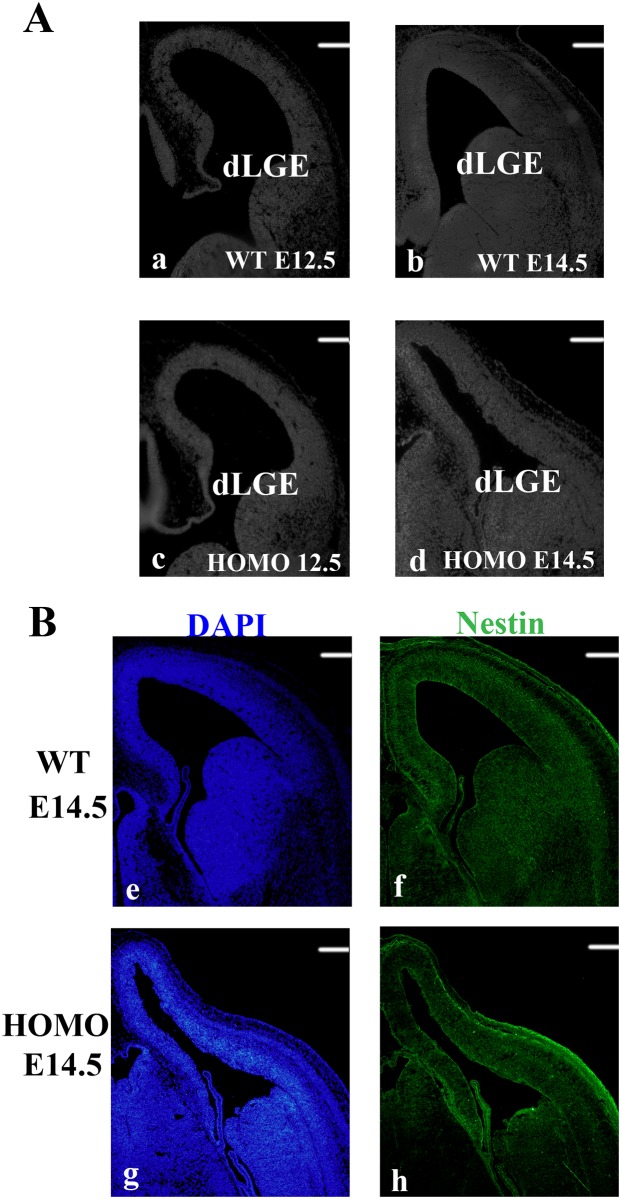
The defects of dLGE in the Lgl1 mutants.(A) At E12.5, there were subtle changes in progenitor zone of the dLGE, while an apparent collapse in morphology at E14.5. (B) Expression of Nestin in the dLGE. Progenitor cell staining by Nestin appeared normal at E14.5. This indicated that progenitor cells of interneurons in the OB could arise from the dLGE normally. dLGE, dorsal lateral ganglionic eminence. Scale bars represent 50 μm.